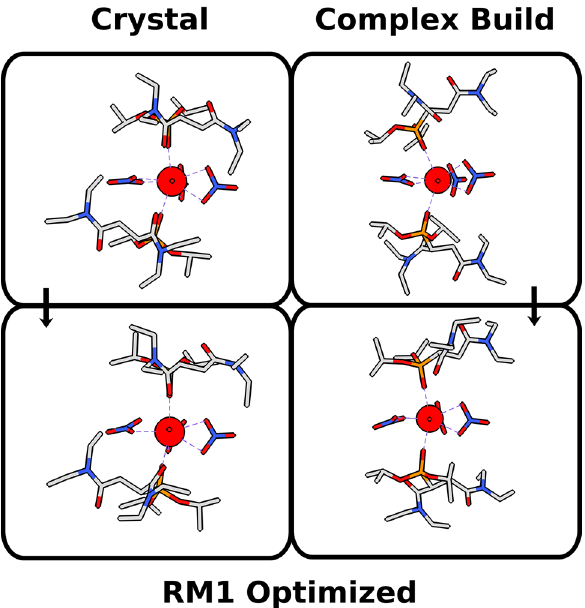
Figure 11. Er(III) complex aqua-bis(di-isopropyl-(1,2-bis(diethylcarbamoyl)-ethyl)-phos phonato)- tris(nitrato-O,O’)-erbium(iii) of stereoisomer ID 16 {[Ma2b(AA)3] MFF-9 C1 c 1 A [2 1 6 4 9 3 5 7 8]} found in CSD by entry DOGKEP. Ligands depicted above and below the metallic centers in the images are large neutral monodentates, with very long, branched and flexible alkyl moieties. These large groups generate images in which the Erbium ion is depicted slightly off the center, something that makes a comparison among the structures a less straightforward affair. We chose to depict this particular orientation, even though it is not immediately obvious that the larger ligands are monodentates. The little circle in front of the erbium atom is the oxygen atom of a coordinated water. Since the two larger ligands and the water are neutral, and each nitrate has a − 1 charge, then the complex is